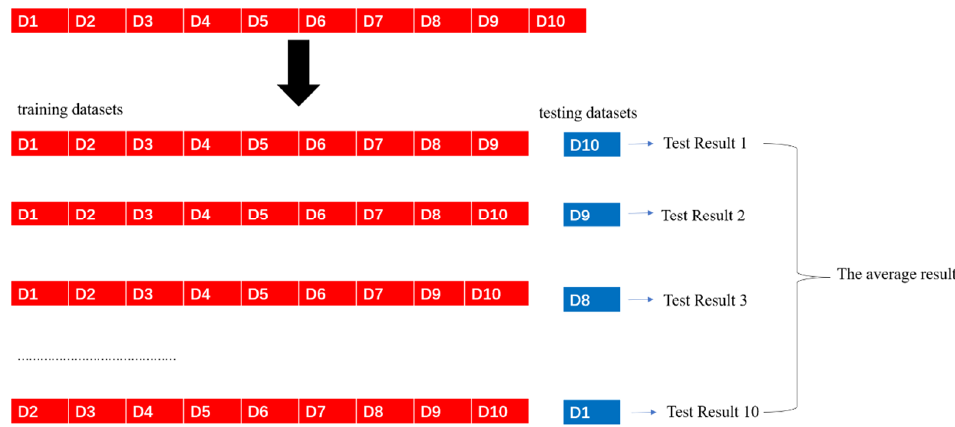
Figure 15. Principle of ten-fold cross validation.